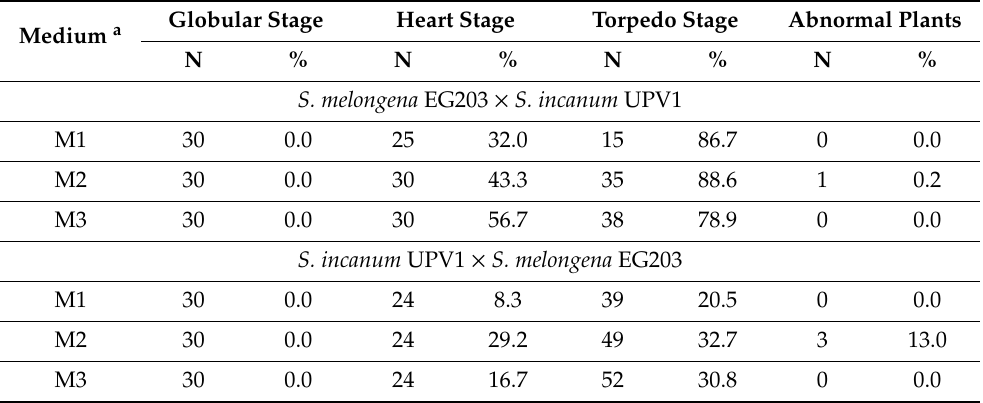
Table 2. E ff ect of tissue culture media on germination (%) of di ff erent embryo stages and abnormal plants of the reciprocal hybrids between S. melongena EG203 and S. incanum UPV1. The number of embryos used for each embryo stage and medium is indicated (N).